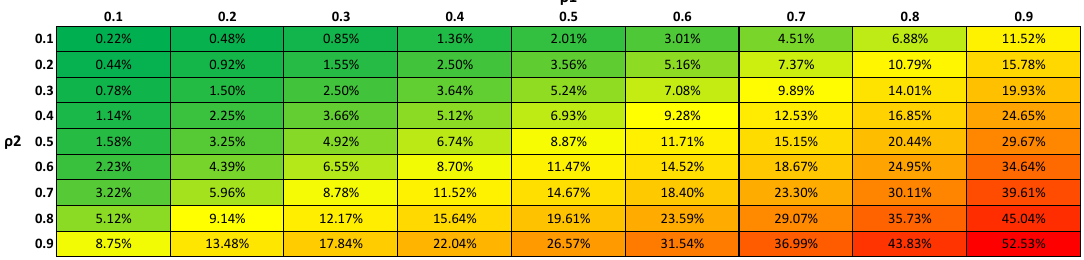
Figure 3. Percentage of road network that must be covered in order to achieve the Delta Network for pairs of ρ 1 and ρ 2 when solving the deployment using Delta-g . Recall that ρ 2 indicates the share of vehicles that must be connected during ρ 1 percent of the trip duration. Results consider the Cologne mobility trace. Source: Silva et al. [53] with kindly